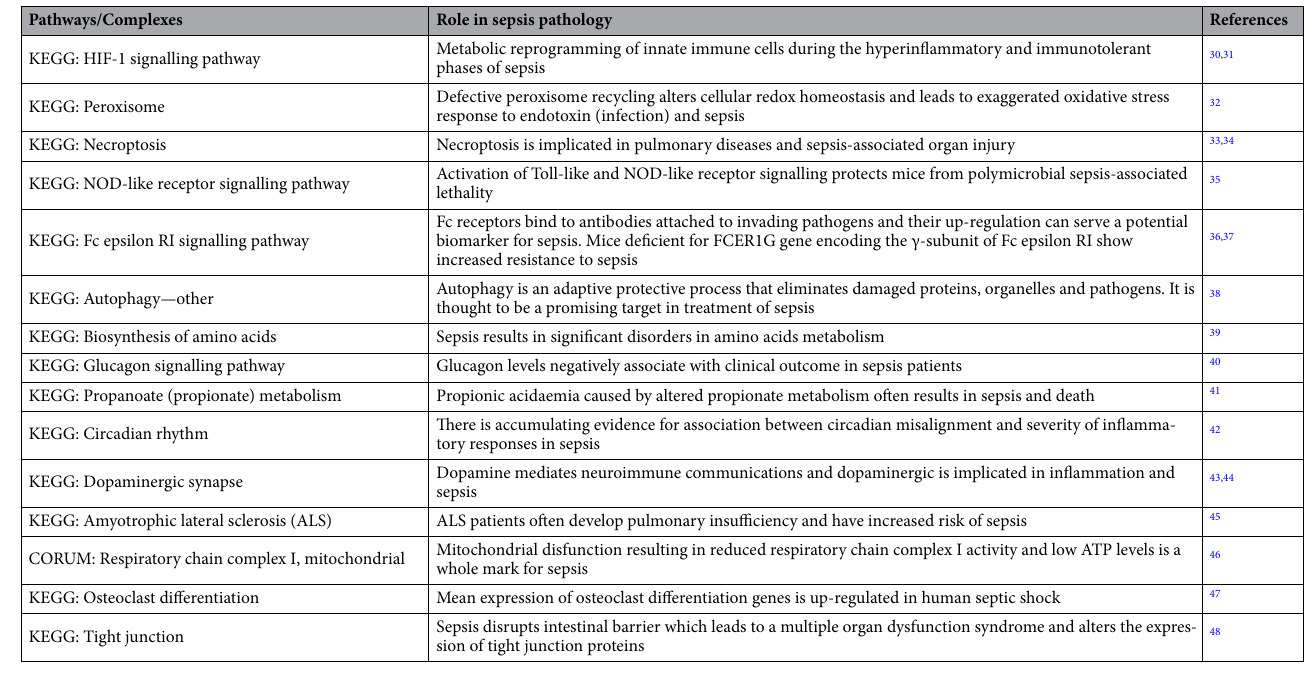
Table 1. Role in sepsis of the pathways for which gene ensemble noise associates positively (increases) with the disease states (healthy < early/survived <